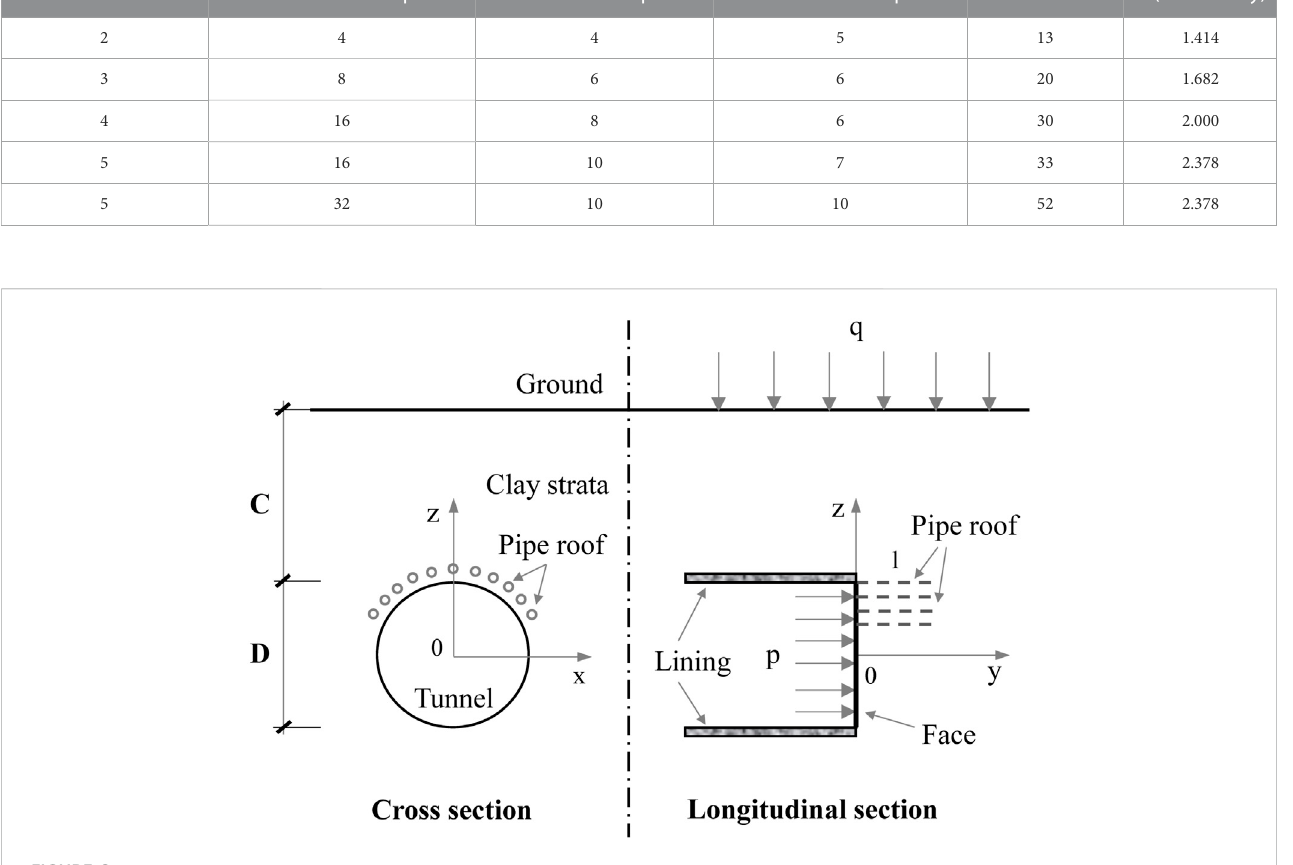
FIGURE 6 Tunnel con fi guration and construction